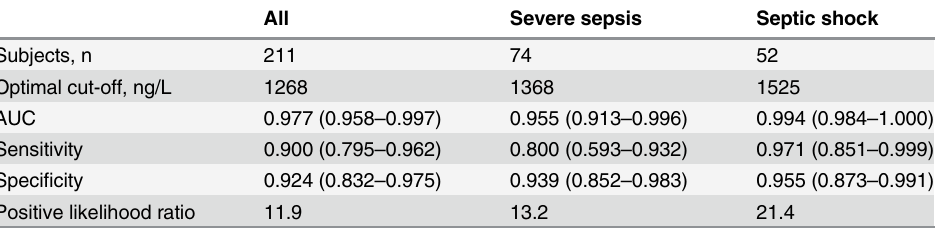
Table 5. ROC analysis determining viability of plasma NT-ProBNP levels for differentiating heart fail- ure in sepsis patients. *